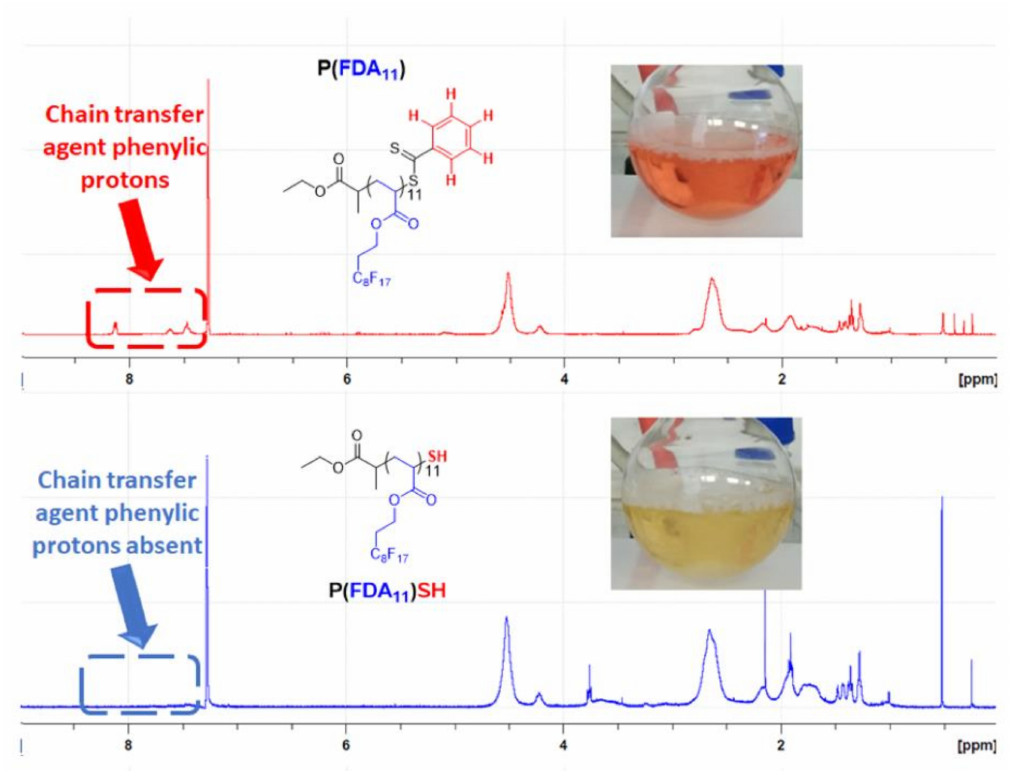
Figure 10. Comparison of the 1 H-NMR spectra (400 MHz, CFC-113 + C 6 D 6 capillaries) and of the color of the reaction mixture in the case of P(FDA) before (top) and after (bottom) aminolysis with